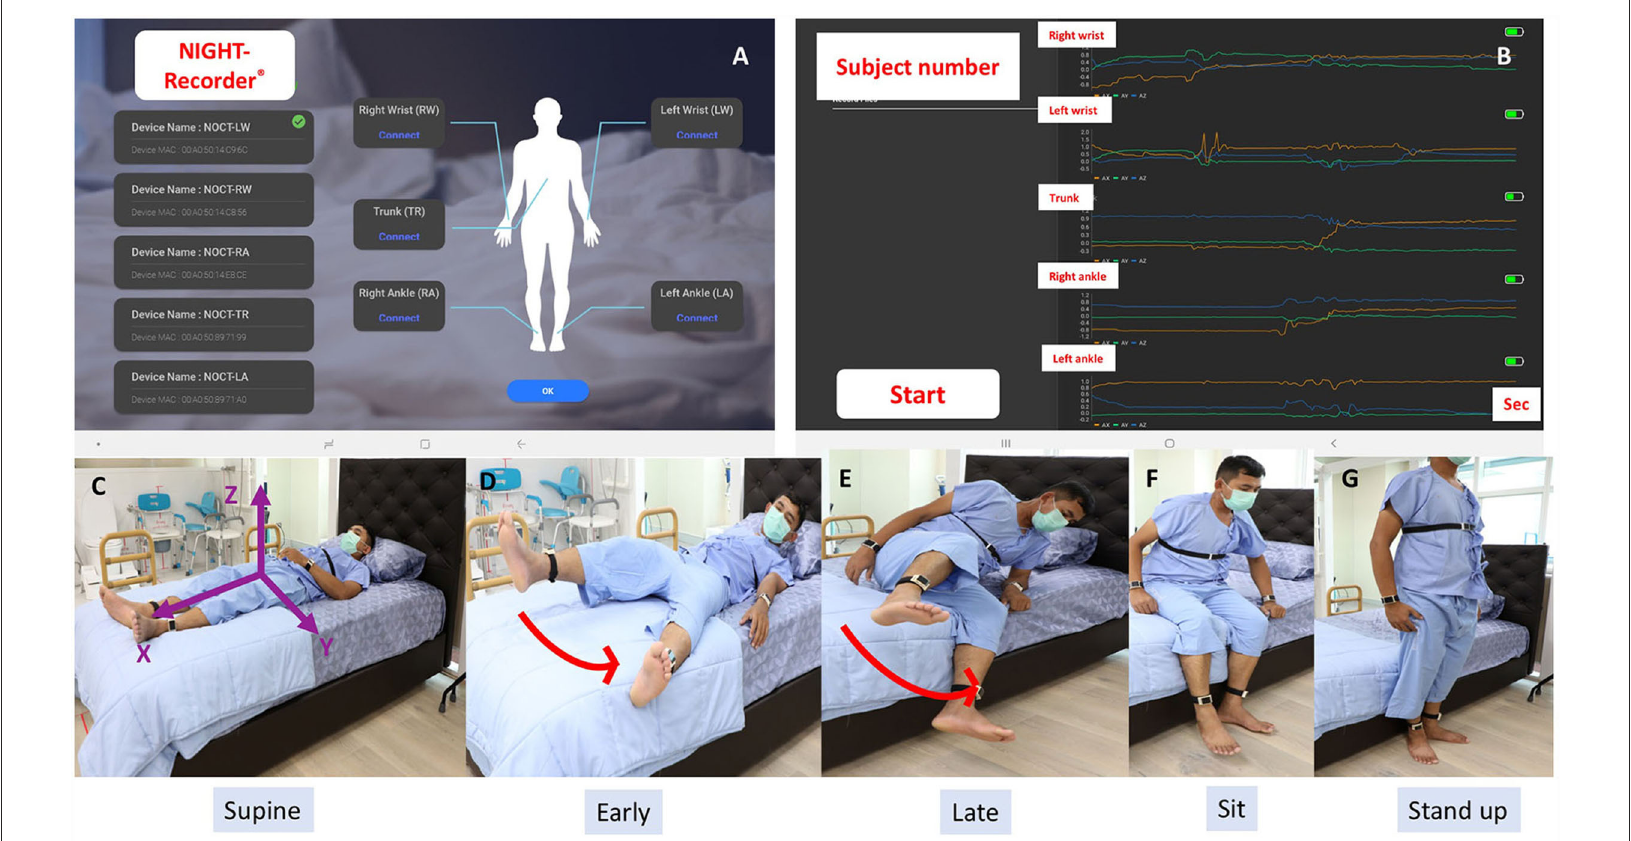
FIGURE1 (A) The NIGHT-Recorder ® application interface demonstrated a successful connection with a set of five wearable sensors. (B) Examples of sensor signals from the NIGHT-Recorder ® during the supine-to-stand .task (orange: x -axis; green: y -axis; blue: z -axis). (C) Three axes ( x , y , and z ) orientation of the trunk sensor. (D–G) Video recording of a control subject demonstrated “leg first” as the first movement pattern of a supine-to-stand